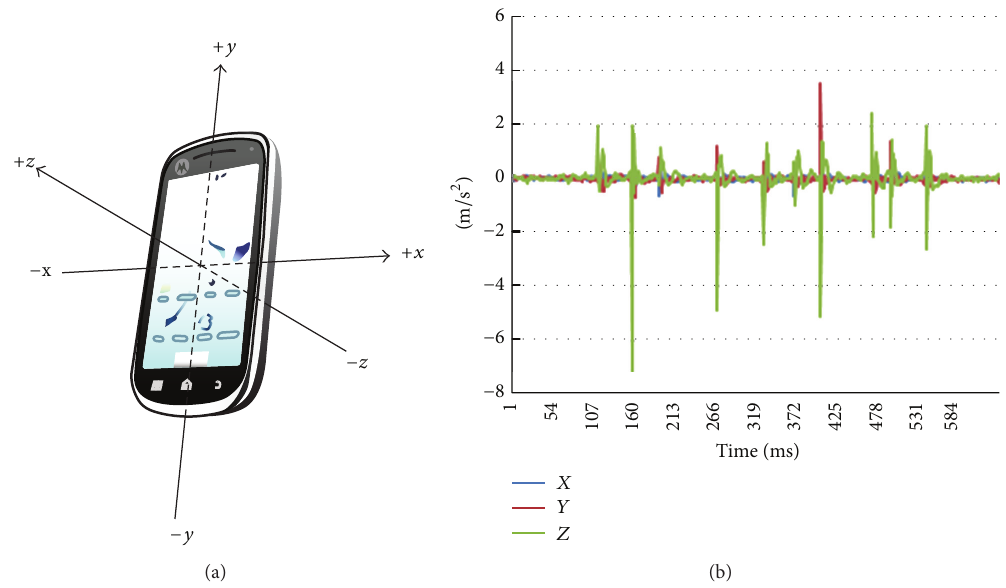
Figure 2: (a) Coordinate system of the accelerometer. (b) Sample of accelerometer readings showing the effect of typing the digits